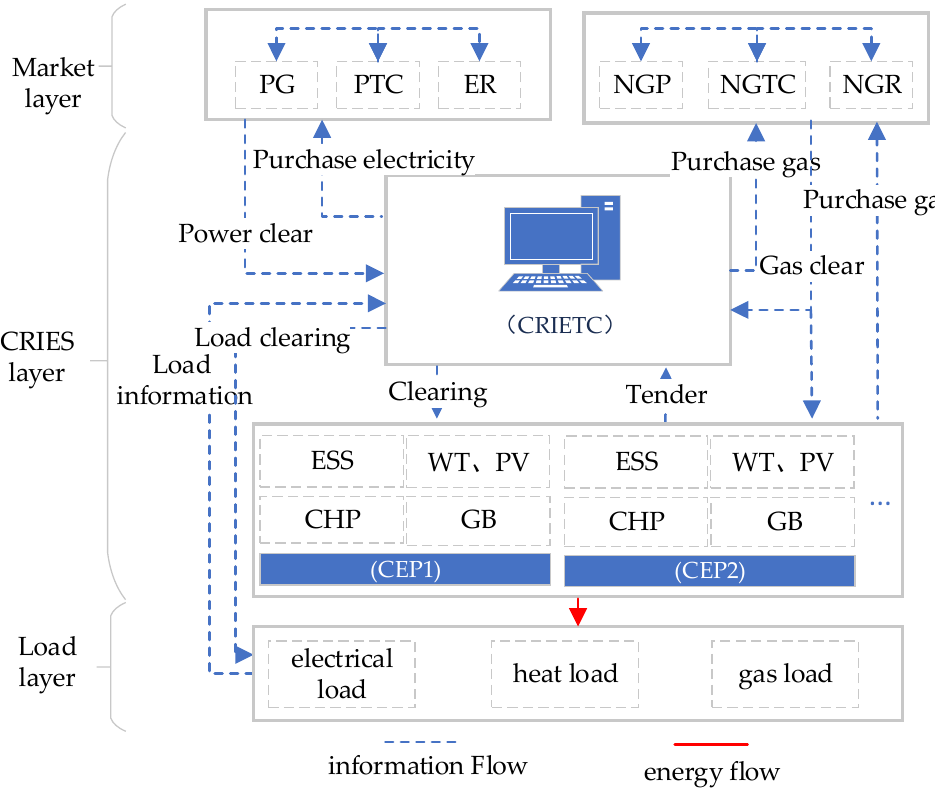
Figure 1. CRIES structure under the energy market.